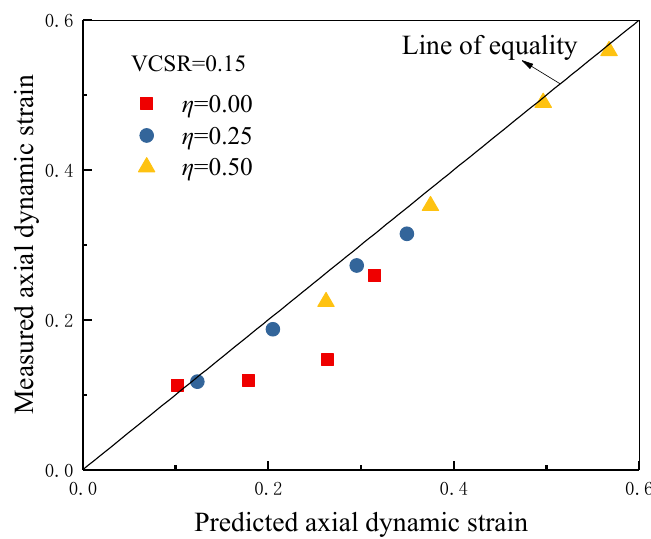
Figure 14. Comparison of predicted and measured axial dynamic strain.